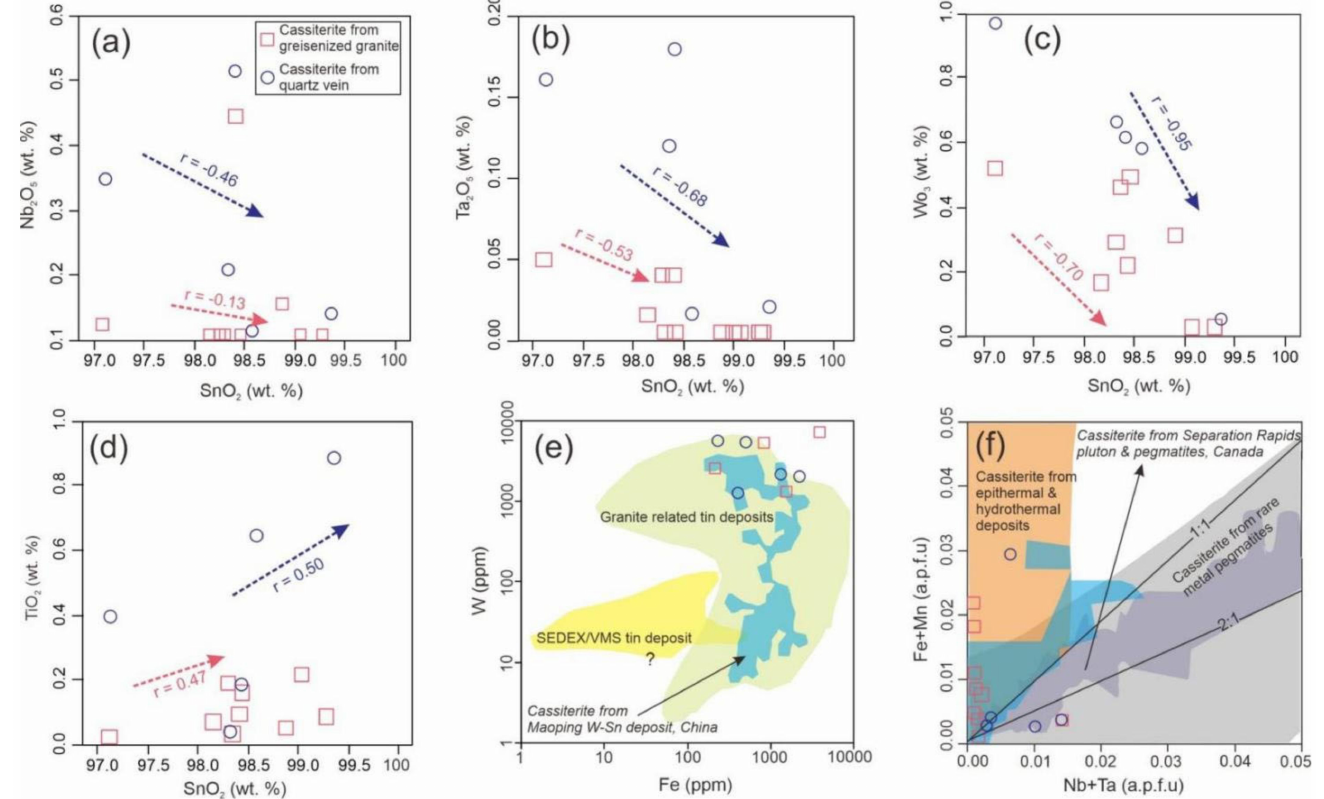
Figure 11. Binary plot of major and trace elements in cassiterite samples from the Gindi Akwati deposit. ( a ) SnO 2 vs. Nb 2 O 5 ; ( b ) SnO 2 vs. Ta 2 O 5 ; ( c ) SnO 2 vs. WO 3 ; ( d ) SnO 2 vs. TiO 2 ; ( e ) Fe vs. W (modified after [48]); ( f ) Nb + Ta (a.p.f.u) vs. Fe + Mn (a.p.f.u) (modified after [49]). Red and blue dashed arrows represent trend of correlation of cassiterite from greisenized granites and quartz veins, respectively. The r values in Figure 11a–d show the correlation